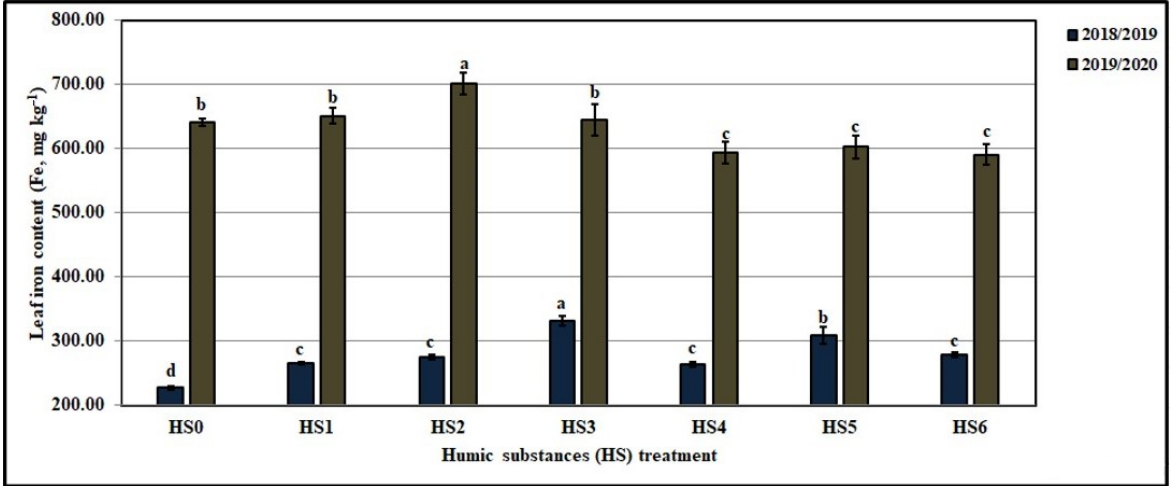
Figure 25. Influence of humic substances treatments on leaf iron contents (Fe, mg kg − 1 ) of some wheat varieties grown in clay loam soil in 2018/2019 and 2019/2020 seasons. Bars in the same years with a different letter indicate significant differences between treatments at p ≤ 0.01. HS 1, HS 2 , HS 3 represent HS applied as foliar spray at 1.0, 2.0, 4.0 g L − 1 , respectively, HS 4 , HS 5 , HS 6 represent HS applied as soil application at 5.04, 7.56, 10.08 kg ha − 1 .